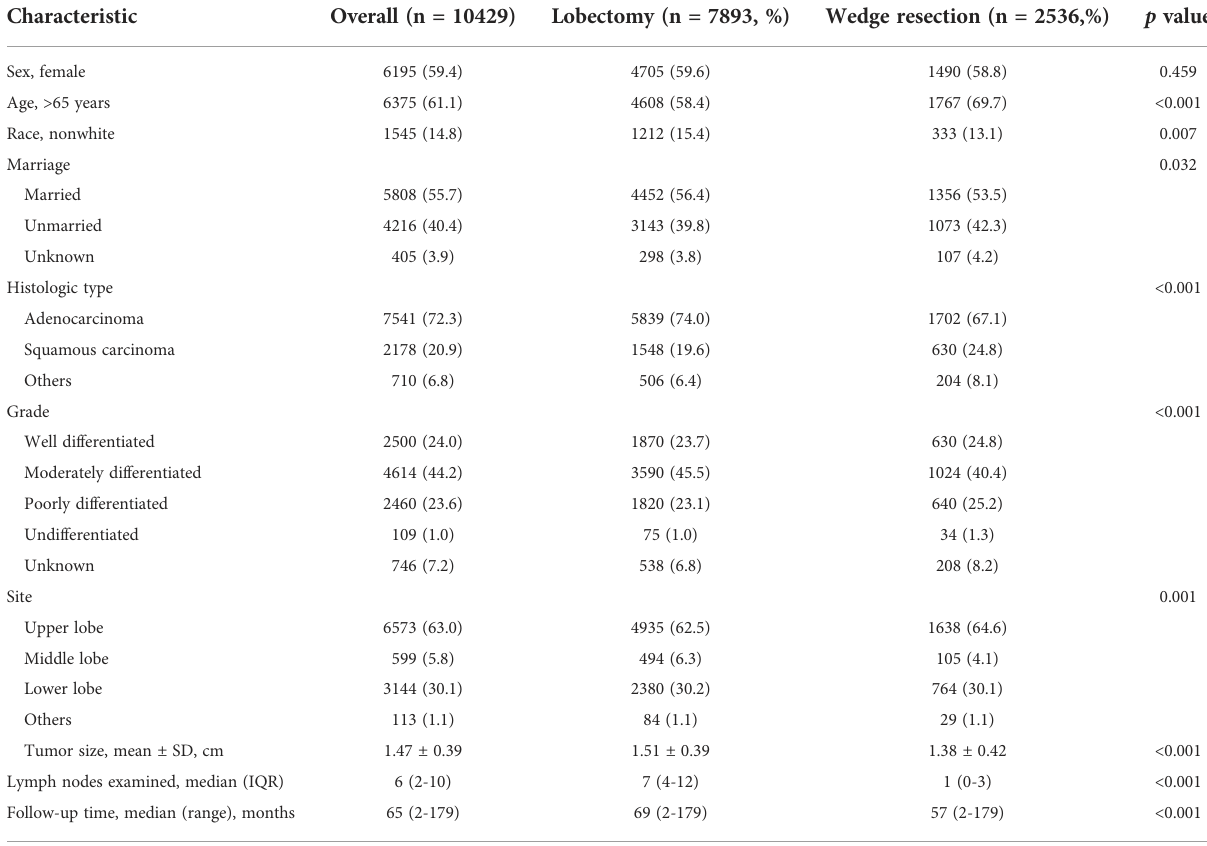
TABLE 1 Baseline characteristics of patients with NSCLC 2 cm or less undergoing wedge resection or lobectomy (n=10429).